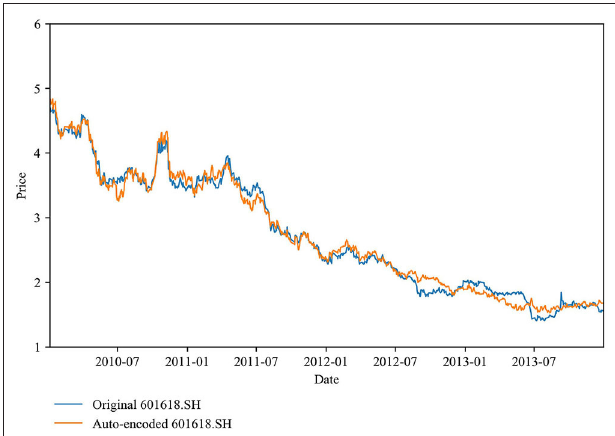
FIGURE 8 | Stock (601618.SH) with the most communal information: the prices of the actual and auto-encoded stocks are nearly the same across the period shown.